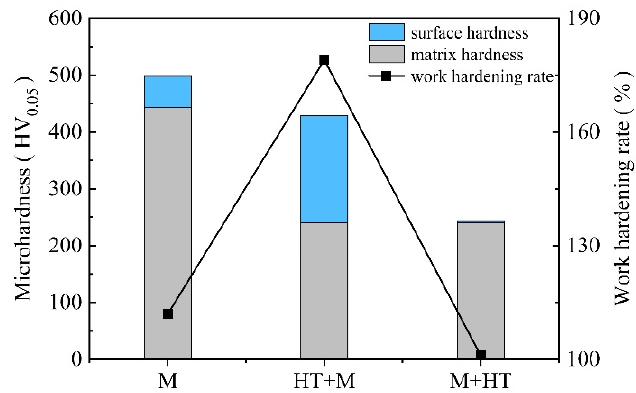
Figure 6. Surface microhardness and degree of work hardening of sequential machined workpieces.